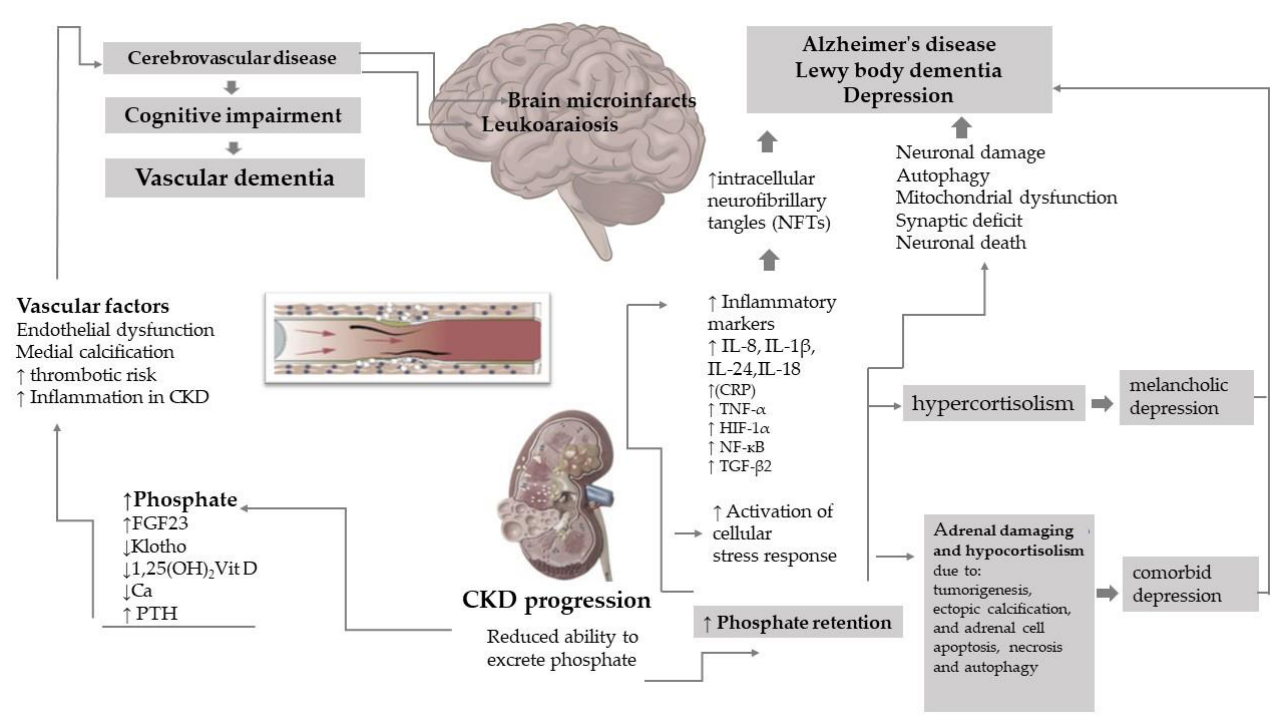
Figure 2. The impact of phosphate toxicity in the brain. Abbreviations: FGF23 — fibroblast growth factor 23; PTH — parathyroid hormone, Ca — calcium; PTH hyperparathyroidism; Vit D — vitamin D; (IL-8)-Interleukin; (IL- 1β) -Interleukin- 1β; (IL -18)-Interleukin-18; (IL-24)-Interleukin-24; (CRP) — C Reactive protein; (TNF- α) -tumor necrosis factor alpha, (HIF- 1α) -hypoxia-inducible factor- 1α, (NFкB) -nuclear factor kappa-light chain-enhancer of activated B cells, (TGF- β2) Transforming growth factor- β2 ; ↑-increased; ↓-decreased.